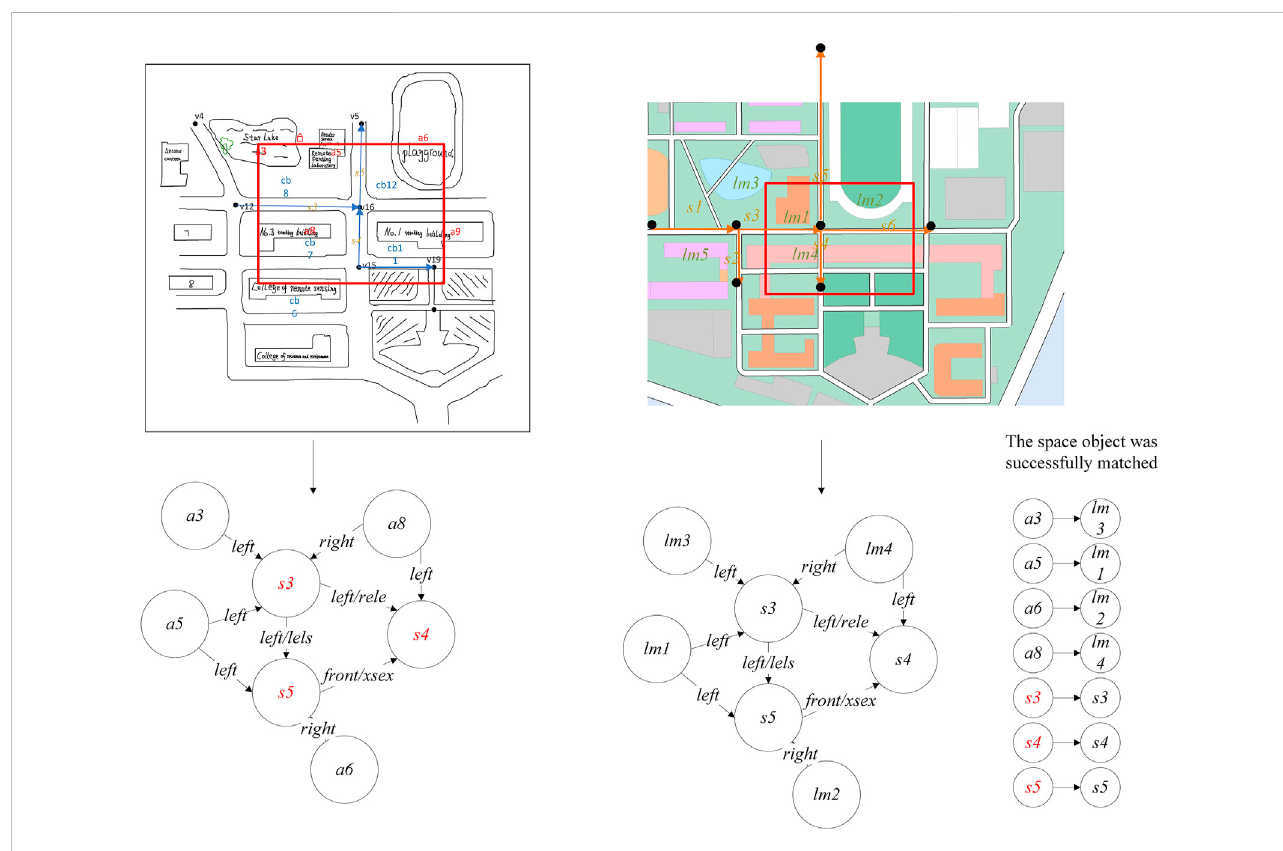
FIGURE 10 Street segment priority matching diagrams.